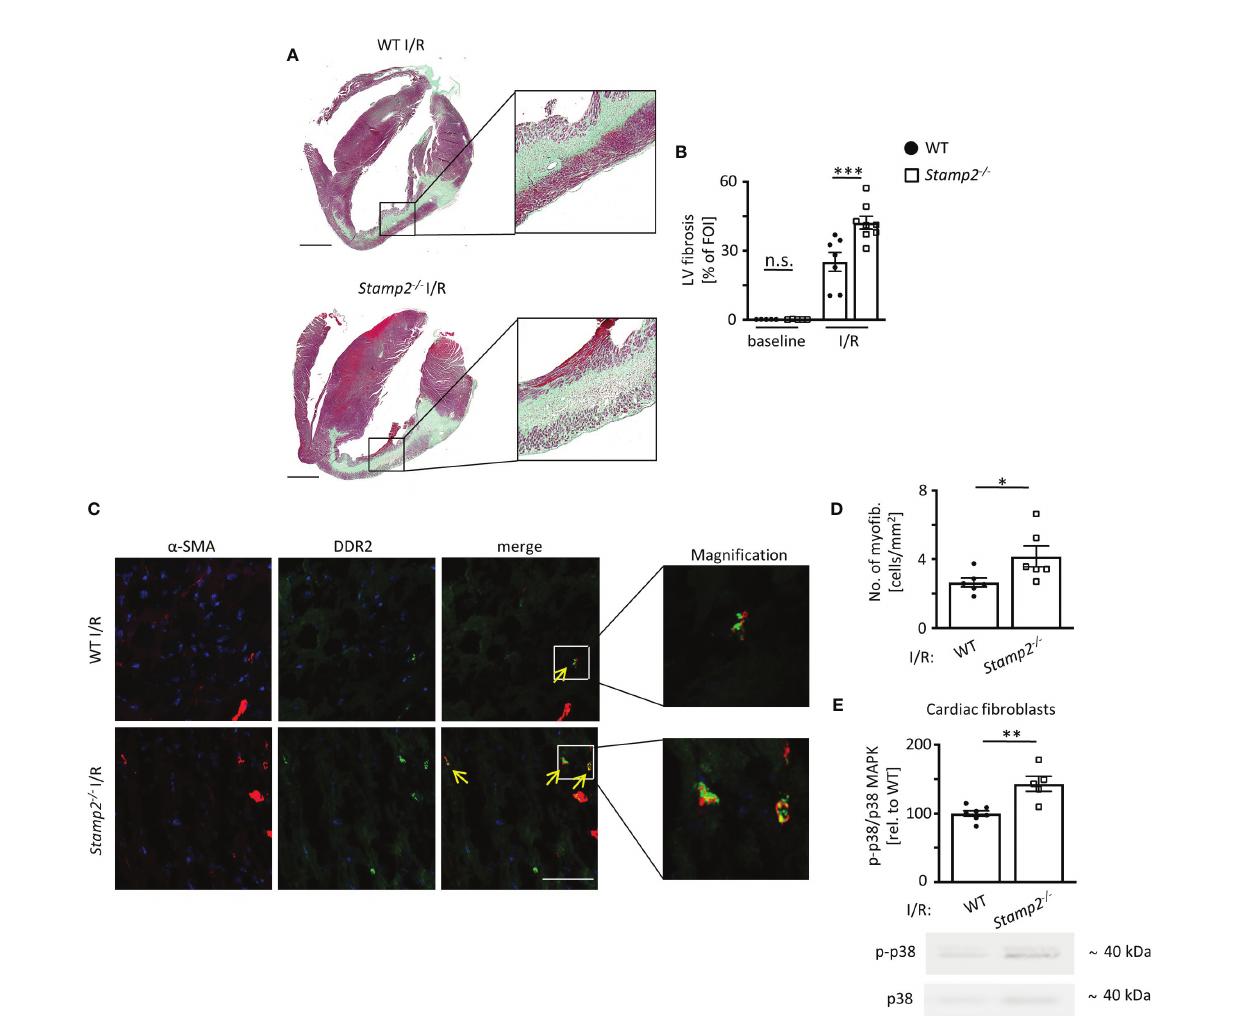
FIGURE 2 | Stamp2 de fi ciency aggravates I/R-induced LV fi brotic remodeling. (A) Representative images of Masson ’ s trichrome-stained cardiac sections of WT and Stamp2 -/- animals 7 days after I/R. Scale bar=1mm. (B) Quanti fi cation of left ventricular fi brotic areas stained in green (n=5/5/7/8). (C) Representative immuno fl uorescence stainings imaged by confocal microscopy for the myo fi broblast marker a -SMA ( a -smooth muscle actin; red), for the fi broblast marker DDR-2 (discoidin domain-containing receptor 2; green) and for nuclei (DAPI, blue). Scale bar=50 m m. (D) Quantitative analaysis of myo fi broblasts within the peri-infarct region (n=6/6). (E) Relative phosphorylation of p38 MAPK (p-p38/p38 MAPK) in isolated primary fi broblasts from hearts 3 days post I/R (n=7/5). Graphs show Mean ± SEM. Full blots are shown in Supplemental Figure S4 . Signi fi cance was determined by two-way ANOVA followed by Tukey post-hoc test (B) or by unpaired Student ’ s t-test (D, E) . *P < 0.05, **P < 0.01, ***P < 0.001. n.s., not signi fi